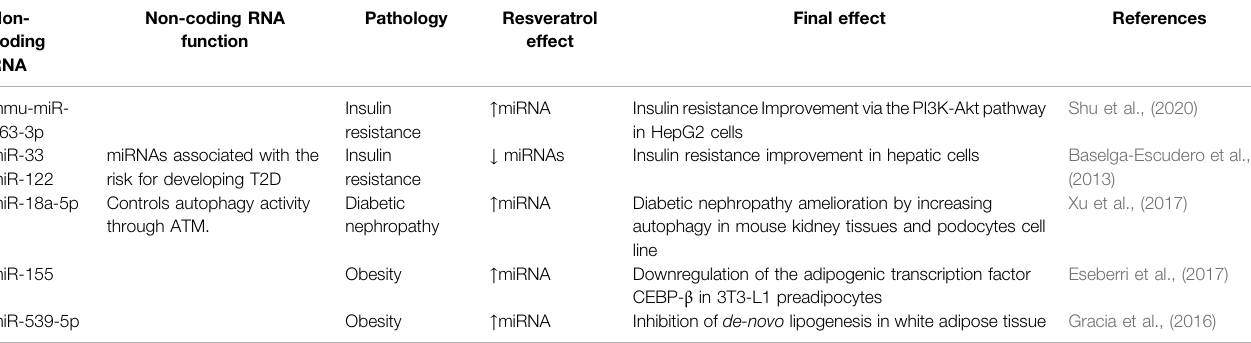
TABLE 1 | Insulin resistance, diabetes and obesity. Non- coding